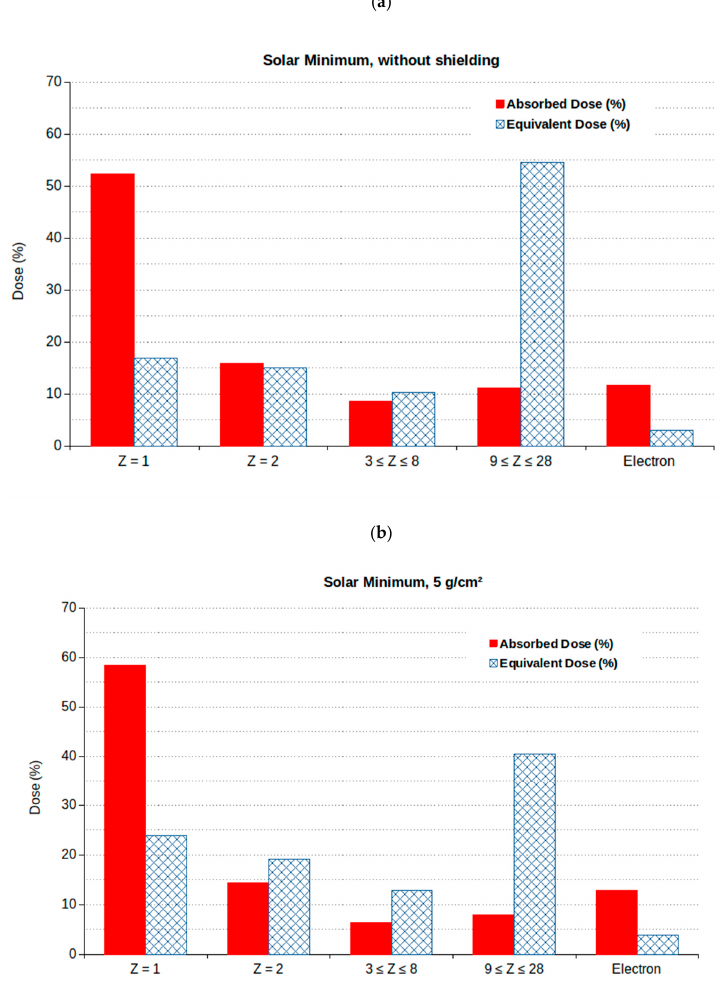
Figure 3. Percentage contribution to the total dose of the different GCR components at solar minimum in case of no shielding (panel a ) or 5 g/cm 2 shielding (Al shielding thickness) (panel b ). Although the figures reported in this paper refer to the solar minimum, which is the most critical condition with respect to the risks related to GCR exposure, analogous calculations were also performed at solar maximum, for which the values of absorbed and equivalent doses were found to be approximately one third of the values at solar minimum.